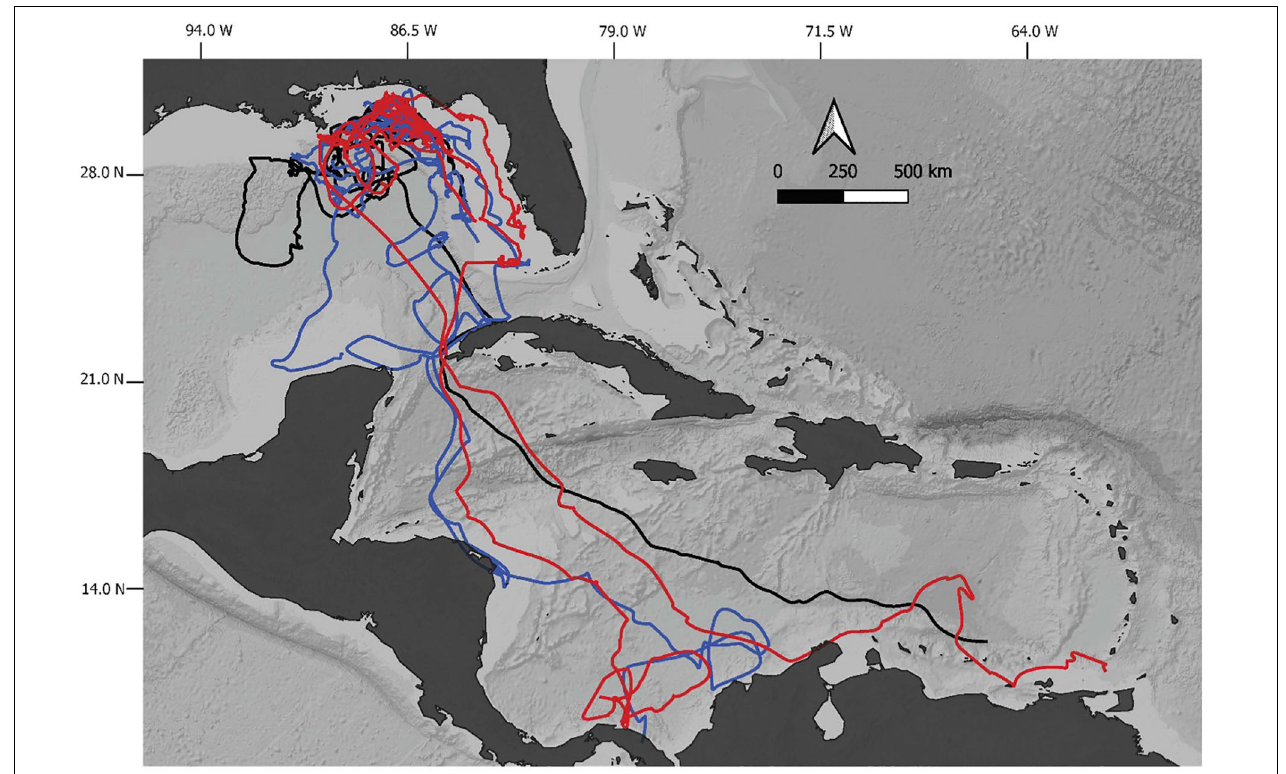
FIGURE 1 | Leatherback tracks by Year 2015 are in red, 2018 in blue, and 2019 in black.